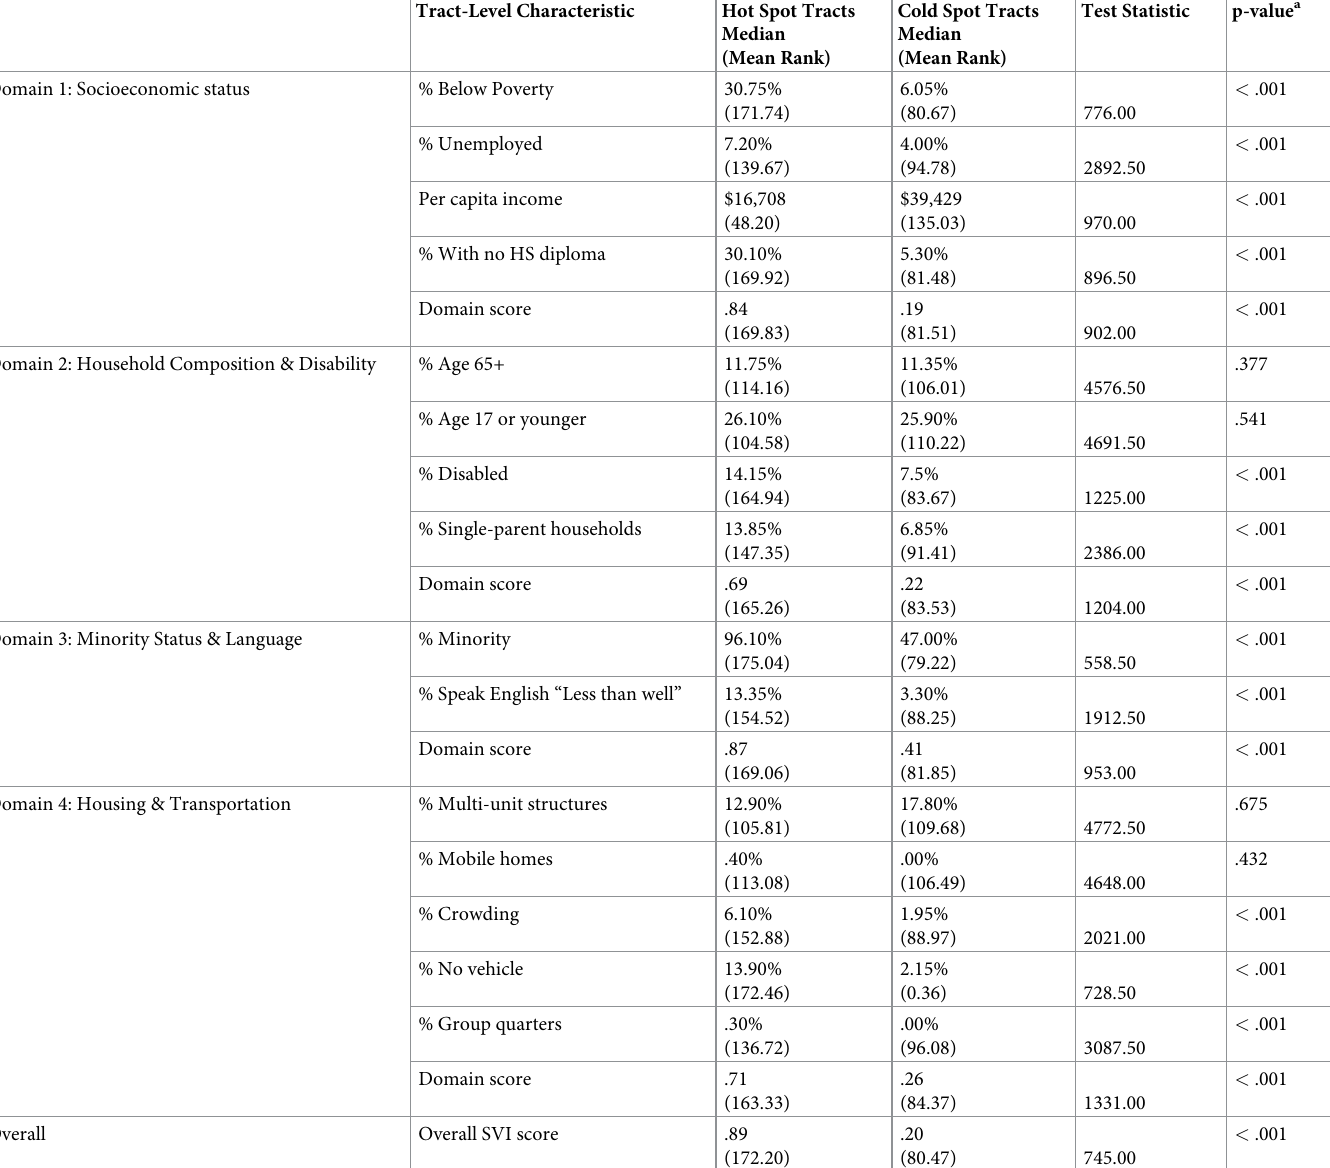
Table 2. Comparison of hot/cold spot tracts of food insecurity incidence, in terms of the CDC’s Social Vulnerability Index, subdomains, and individual components. Tract-Level